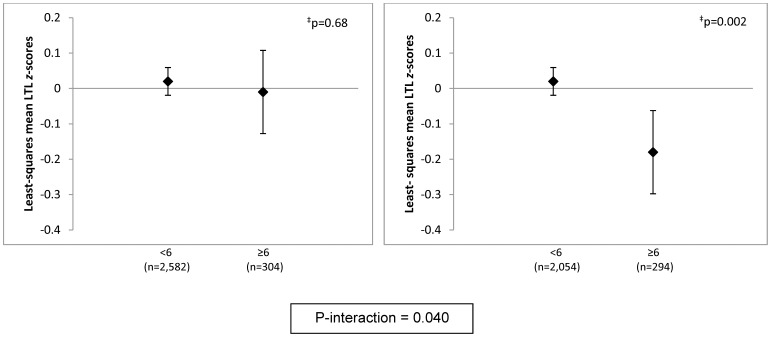
Adjusted* least-squares mean leukocyte telomere length z-scores, by phobic anxiety level, stratified by body mass index (<25 kg/m2 or ≥25 kg/m2).*, Models were adjusted for age in years (continuous), paternal age-at-birth (15–24, 25–29, 30–34, 35–39, ≥40 years), pack-years of smoking (0, >0 to <20, 20 to <40, ≥40), and physical activity (continuous, MET-hrs/wk). Least squares means and 95% confidence intervals are shown. N = 9 excluded due to missing body mass index. ‡, P-value for test of difference in least-squares means.